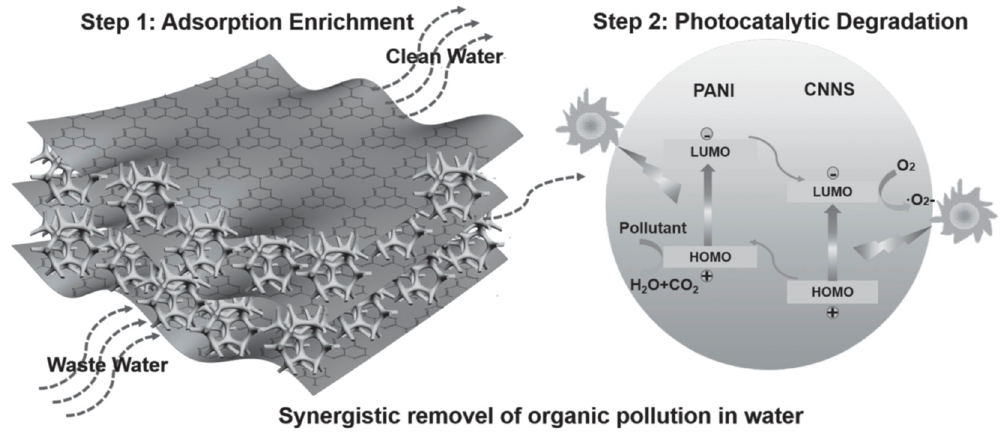
Figure 6. Schematic illustration of the synergistic removal of organic pollution by PANI/CNNS composite photocatalysts [40].